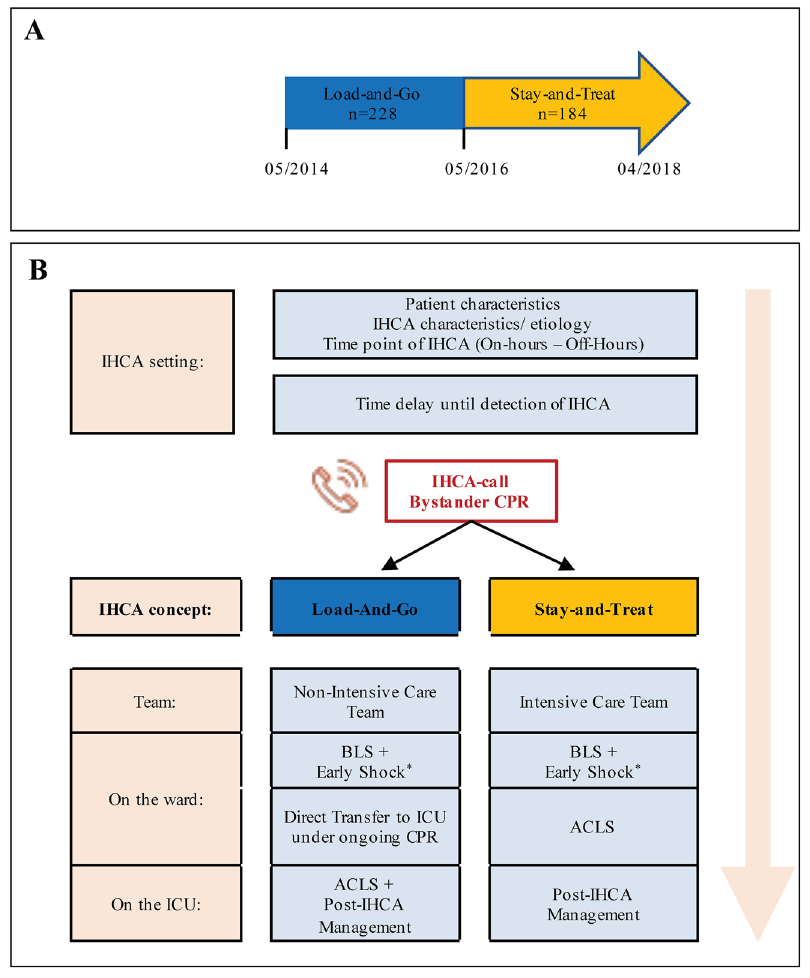
Figure 1. Cardiac arrest team concepts for the management of IHCA. ( A ) From May 2014 to April 2016, IHCA patients were supplied by a Load-and-Go (LaG) concept. From May 2016 to April 2018, the ICU provided a cardiac arrest team that managed IHCA using a Stay-and-Treat (SaT) concept. ( B ) Outcome of IHCA was determined by the setting at which IHCA occurred, time delay until detection and IHCA call was performed, and possibly by the characteristics of the IHCA team concept (focus of the present study). IHCA In-hospital cardiac arrest, CPR cardiopulmonary resuscitation, ICU Intensive Care unit, ACLS Advanced cardiac life